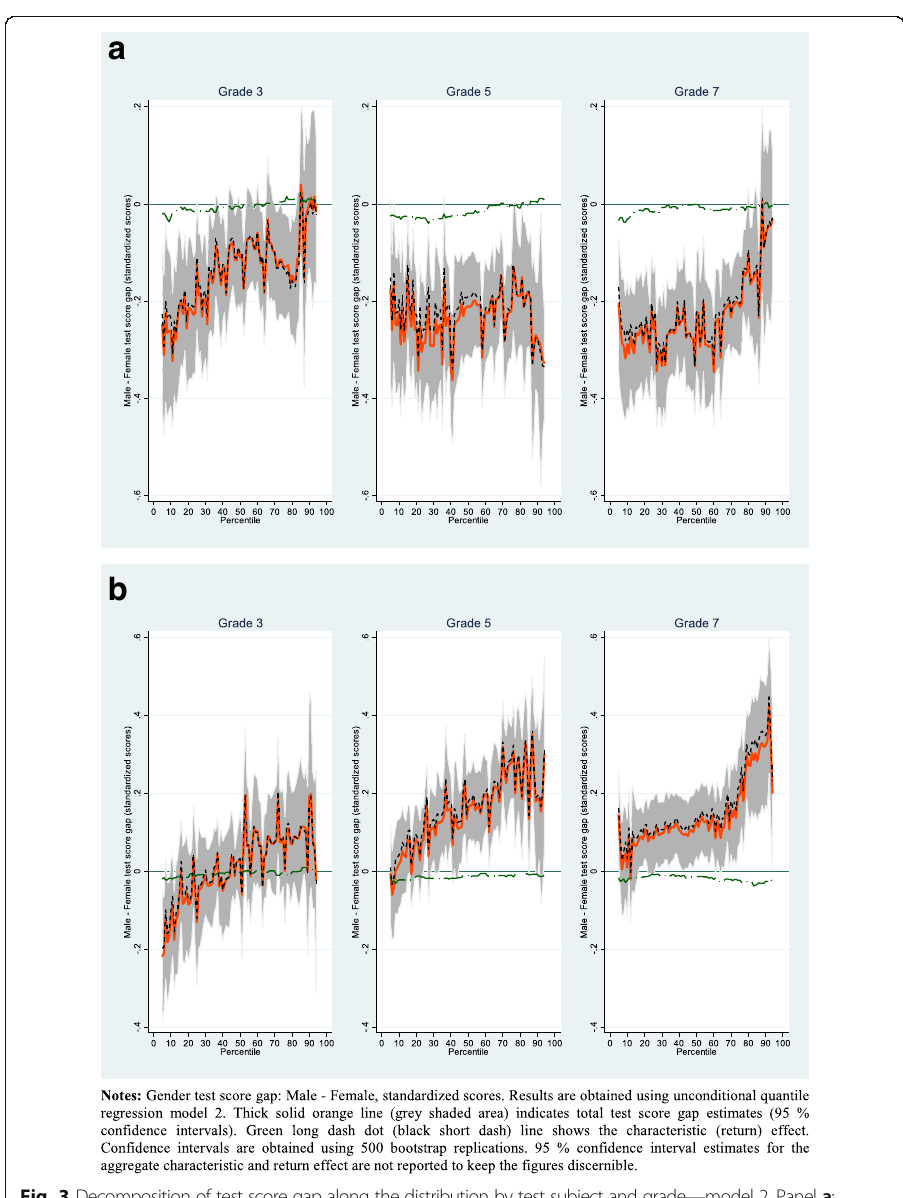
Fig. 3 Decomposition of test score gap along the distribution by test subject and grade — model 2. Panel a : Reading. Panel b :